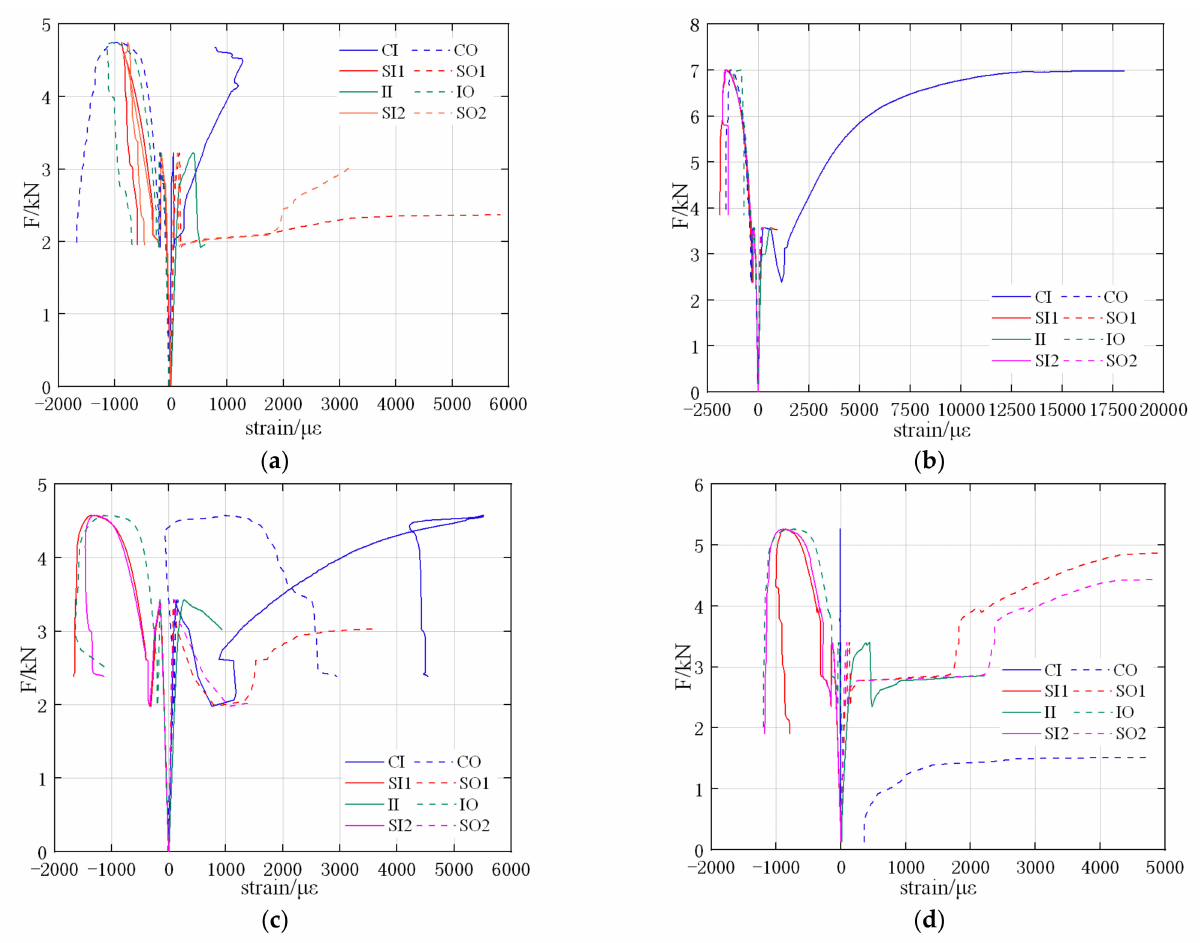
Figure 11. Load-strain curves of TEBTs. ( a ) T1; ( b ) T2; ( c ) T3; ( d )